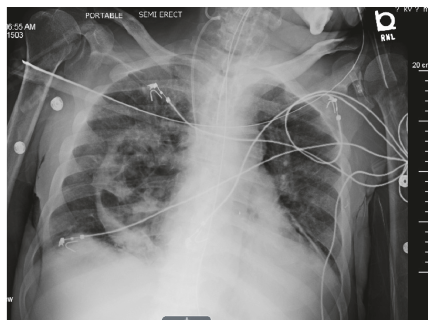
Figure3:ChestX-rayshowinganewpatchyrightlowerlobeopacity consistentwithpneumoniaandpersistentpneumopericardium(day